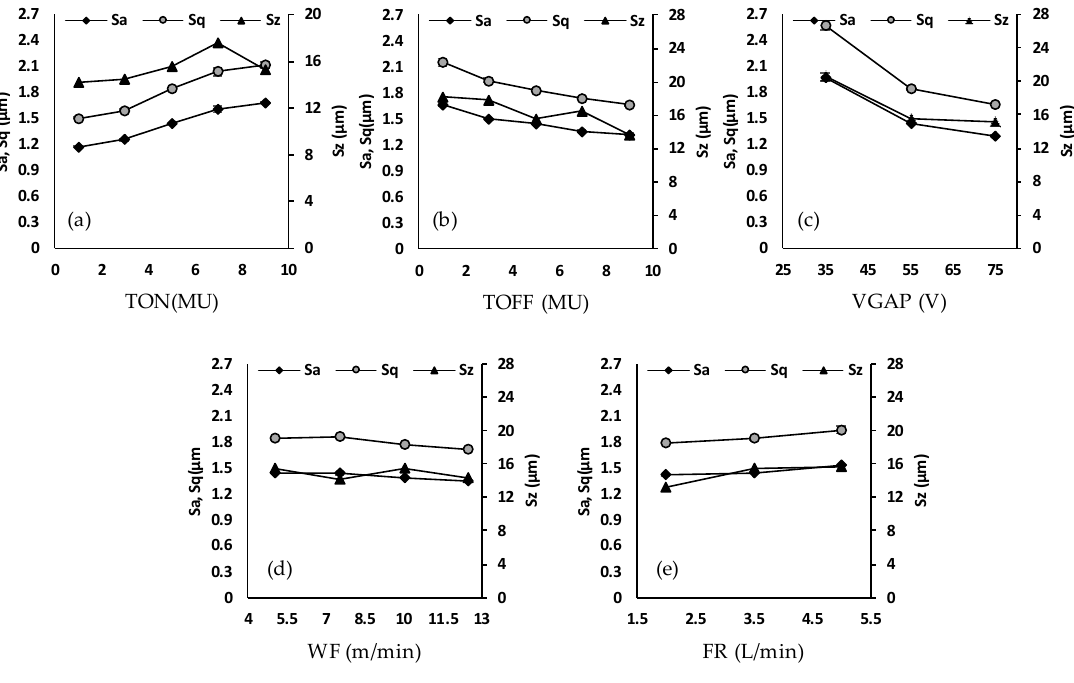
Figure 8. Effect of ( a ) pulse-on time, ( b ) pulse-off time, ( c ) average voltage gap, ( d ) wire feed and ( e ) flow rate on surface roughness ( Sa, Sq and Sz ).